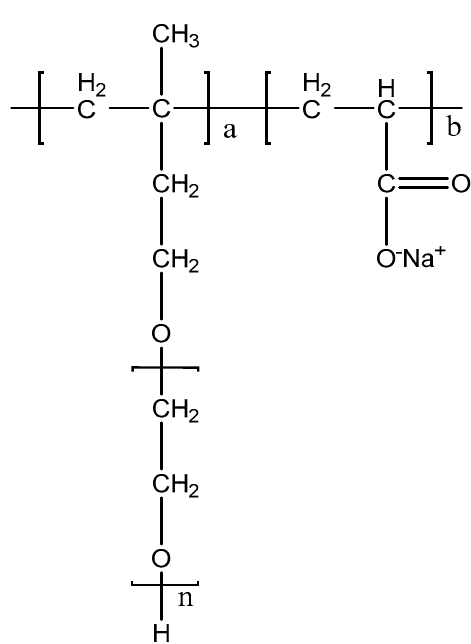
Figure 1. Molecular formula of water-reducing polycarboxylic acid superplasticizer J.